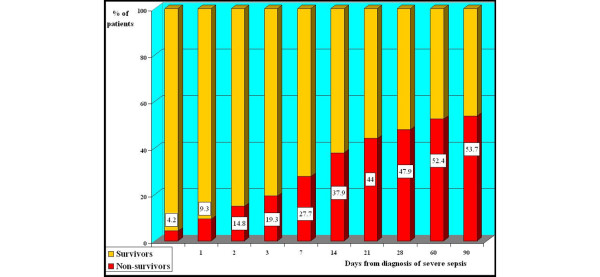
Cumulative hospital mortality. Numbers in squares: cumulative mortality in different days.